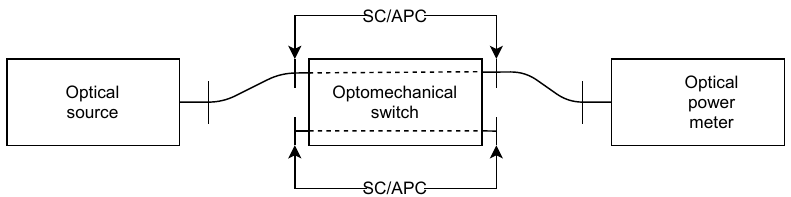
Figure 13. Measurement scheme for an optomechanical switch.